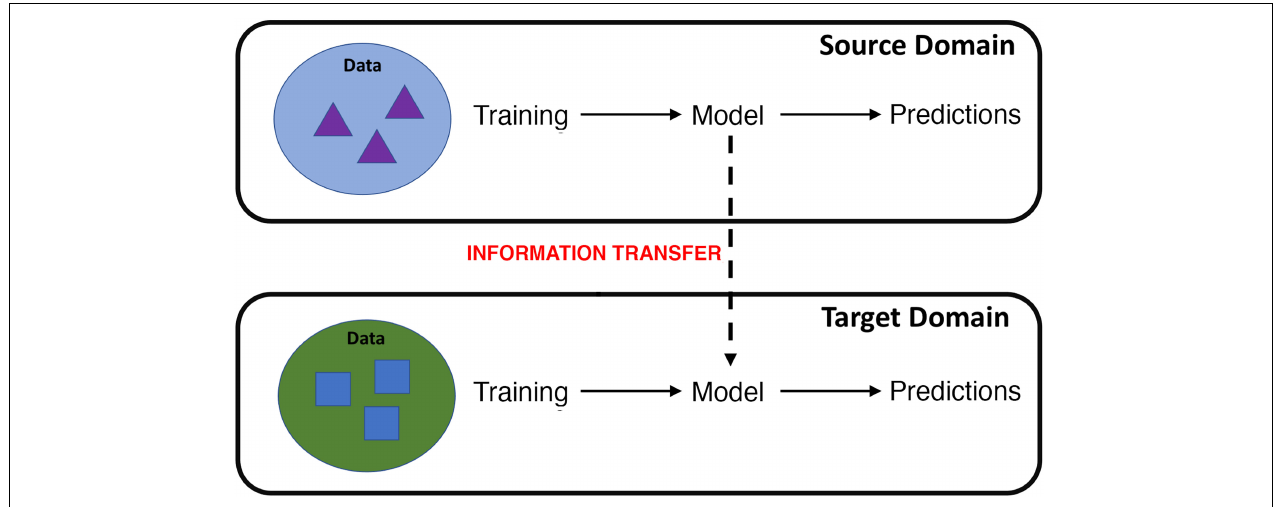
FIGURE 1 | Cartoon illustration of transfer learning, where information learned from a source domain is transferred to learning in a target domain. For example, information learned from fMRI data collected during a particular cognitive task or scanning procedure can be transferred to improve learning on data gathered from a different cognitive task or scanning